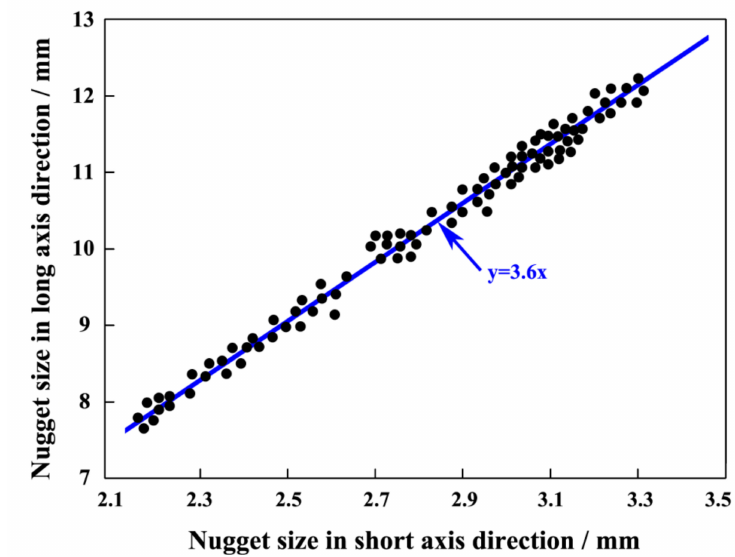
Figure 6. Dimension distributions of the long axis and short axis of welded